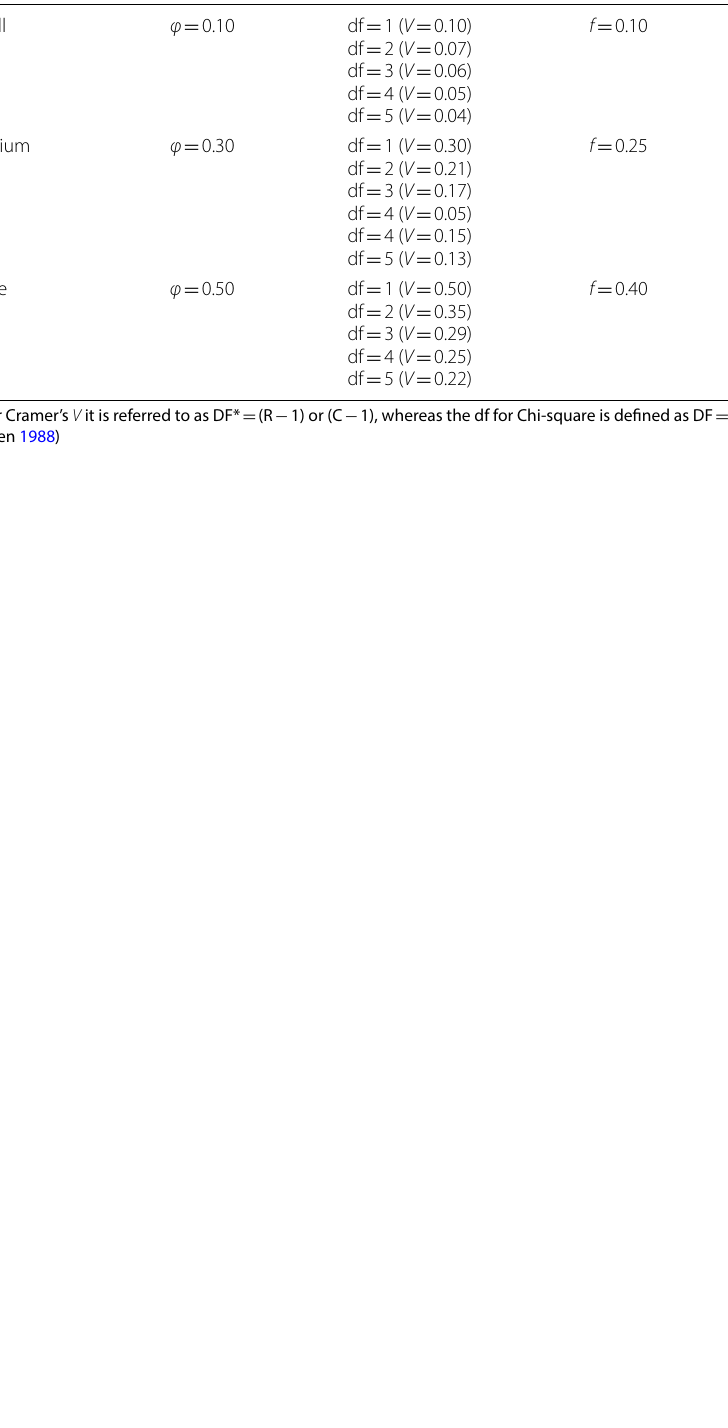
Table 5 Interpreting of Effect Sizes for Phi φ , Cramer’s V , Cohens’s f , and Cohen’s d